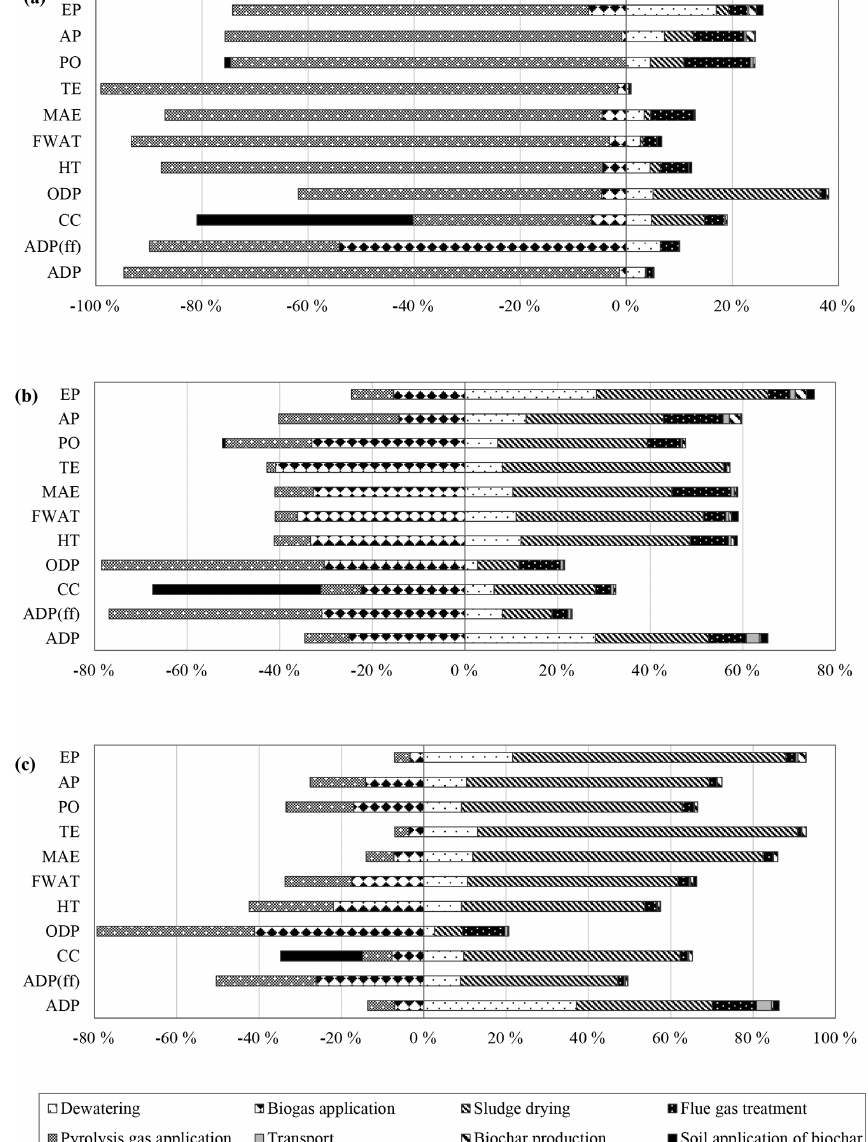
Figure 3. Contribution of life cycle stages to total environmental impacts of the different pathways. (a) System A: biogas for the transportation sector in Sweden, (b) System B: biogas for CHP plants in Brazil, and (c) System C: biogas for cooking in